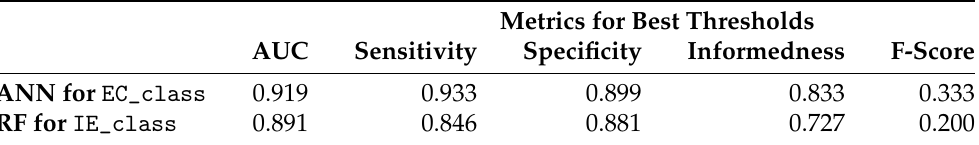
Table 7. Cross validation results of best models (after tuning the parameters—features and probability thresholds).